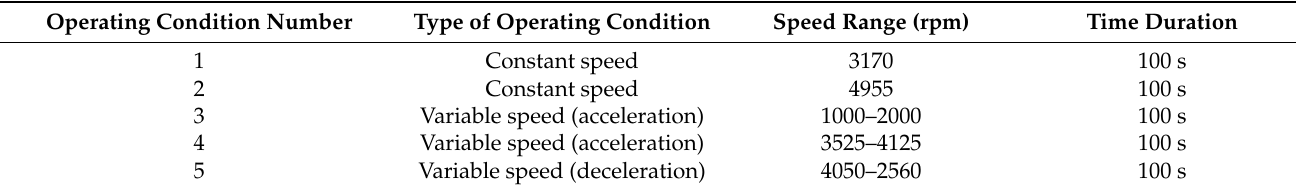
Table 4. Bearings defect classes considered in case study-2.